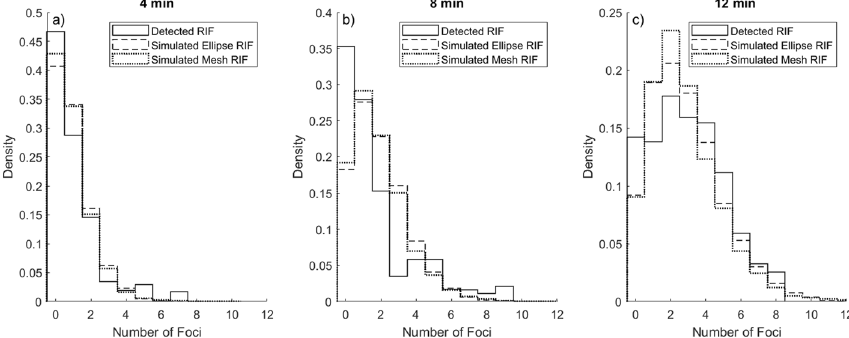
Fig. 10 Detected RIF distribution compared with simulated RIF distributions after adjusting for missed foci for the elliptical cylinder phantom and mesh volume phantom, respectively. Results for 4 min ( a ), 8 min ( b ), and 12 min ( c ) of alpha 241 Am source